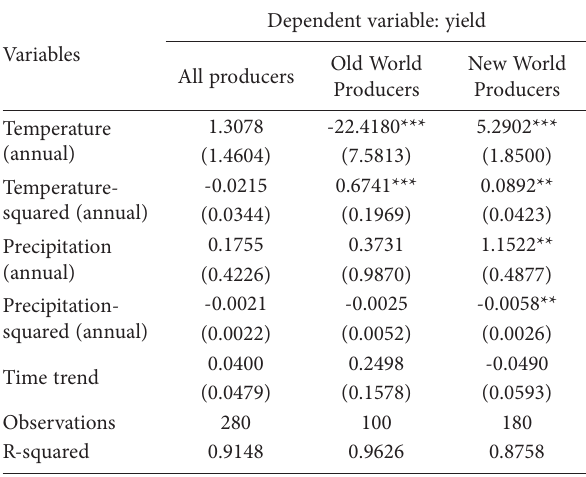
Table A.2. Estimation results for grapevines yields, OLS. Table A.3. Estimation results for grapevines yield: controlling for different combinations of fixed